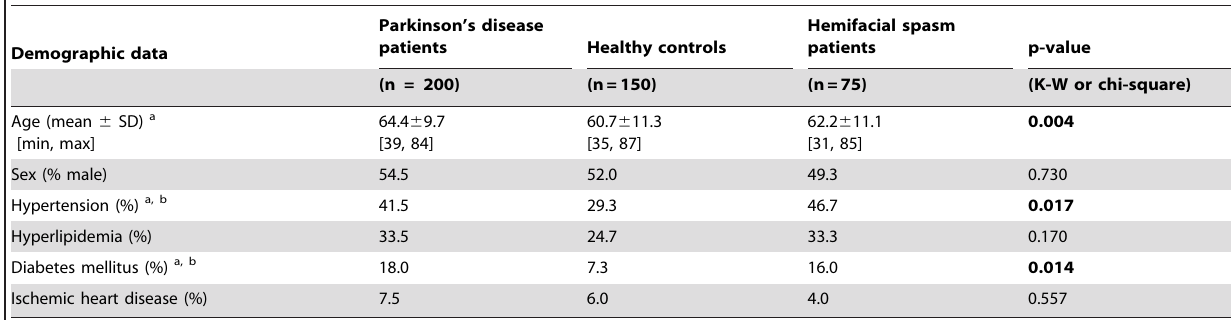
Table 1. Demographic data.